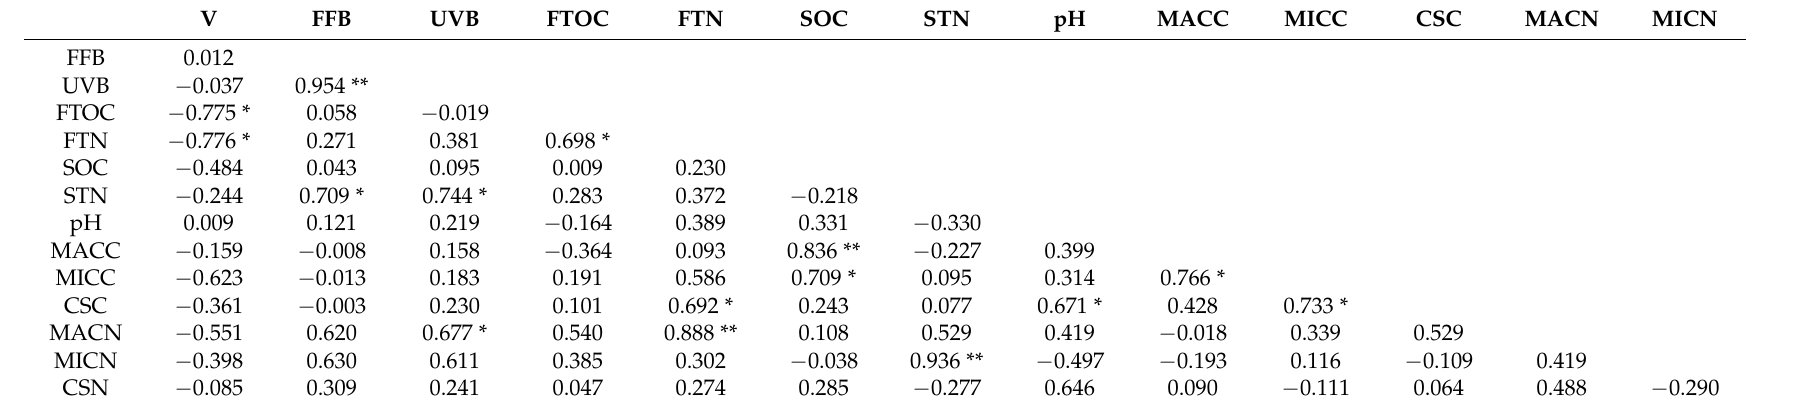
Table A1. Pearson correlation between tree growth and soil properties.